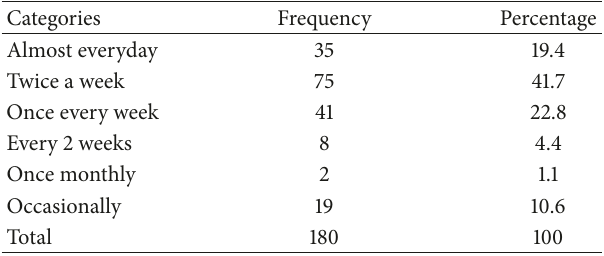
Table 2: Socioeconomic characteristics of respondents. Table 3: Local rice consumption pattern of households in the